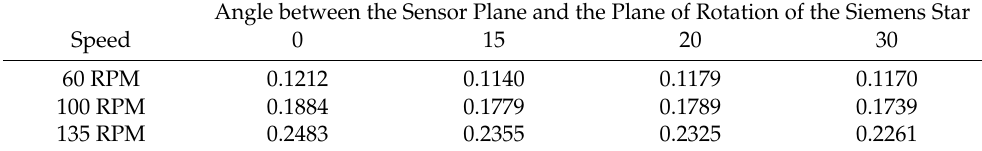
Table 2. Ratio of zero-value pixels in depth maps with real motion. Angle between the Sensor Plane and the Plane of Rotation of the Siemens Star